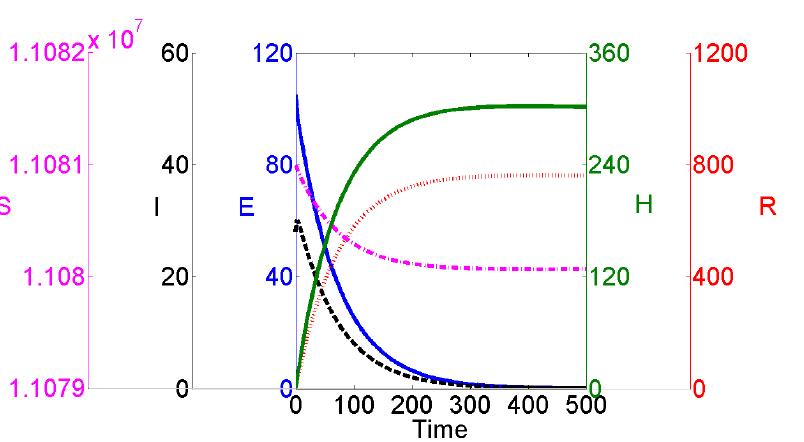
Figure 8. The dynamics of the model equation for the disease-free steady state with R 0 < 1.